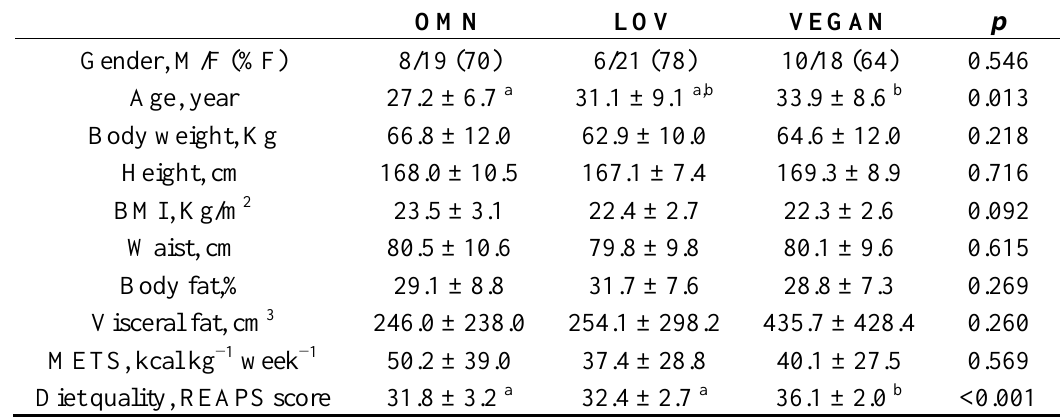
Table 1. Participant characteristics by diet group (omnivorous, OMN; lacto-ovo vegetarian, LOV; vegan, VEGAN) 1